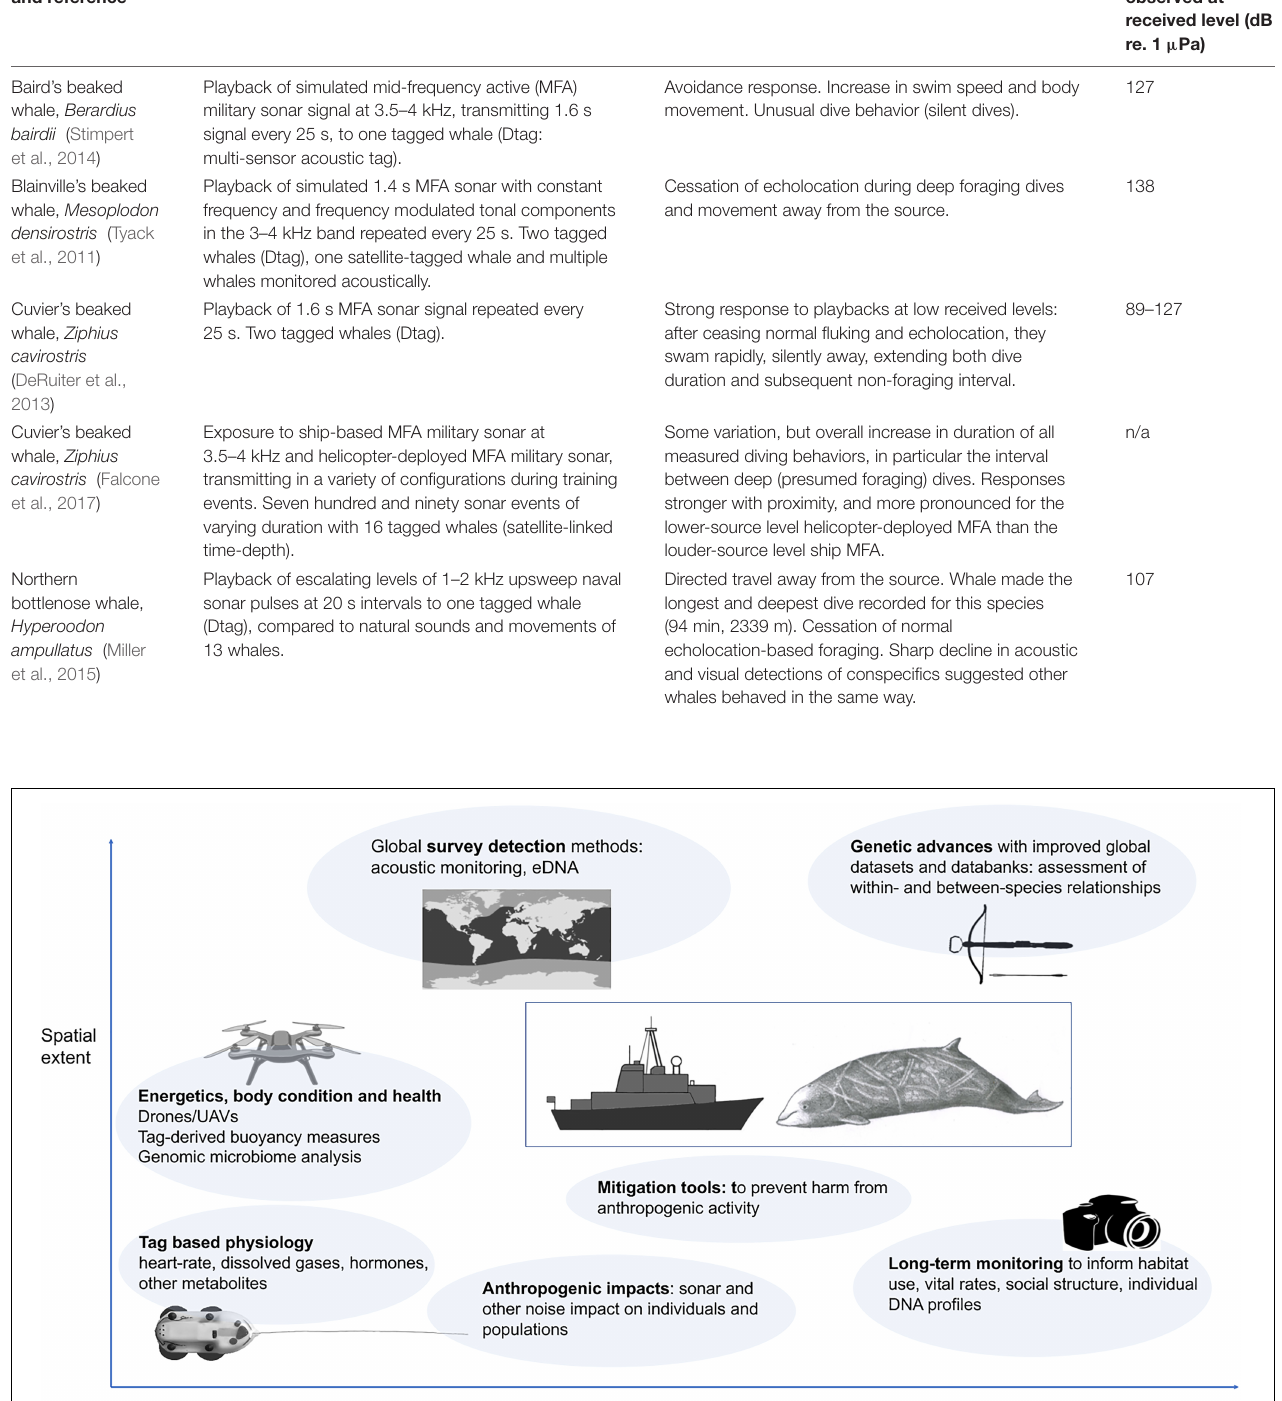
TABLE 2 | Responses of beaked whales to anthropogenic sonar sources. Study species and reference